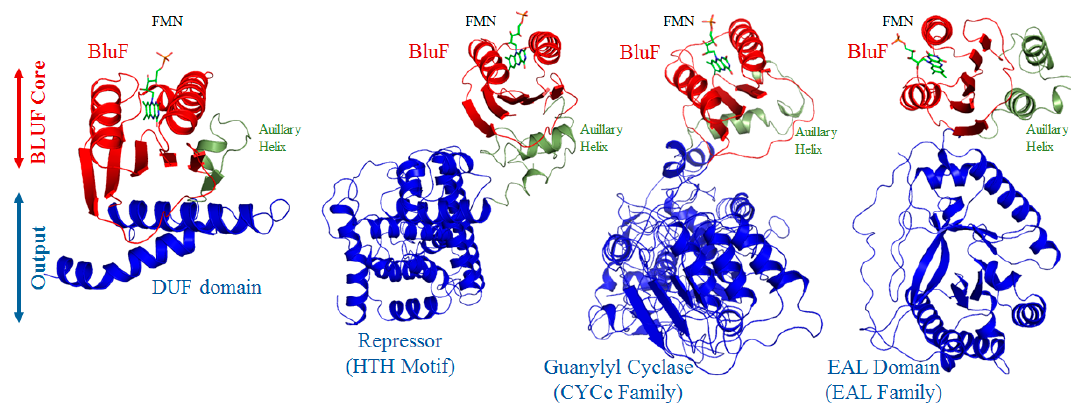
Figure 5. Representation of 3D structural models of BLUF (Red) and e ff ector domain combinations (Blue) using the Phyre server [54]. ( A ) WP_0229622806.1 ( Pseudomonas pelagia ) (206 aa) codes a combination of the BLUF (5–101) and DUF domain (99–181). The model was generated with 100% confidence covering 1–186 residues using the R. sphaeroides AppA (PDB: 4HH0) as the template. ( B ) WP_051596720.1 ( Curtobacterium sp. UNCCL17) (470 aa) codes for BLUF in combination with the transcriptional repressor (224–327). The model was generated with > 90% confidence covering 1–350 residues using 12 di ff erent templates. ( C ) Q8S9F2.1 ( Euglena gracilis ) (1019 aa) codes for BLUF in combination with cyclase homology domains (CHDs), which are part of the class III nucleotydylcyclases (20–379). The model was generated with > 90% confidence covering 1–800 residues using 13 di ff erent templates. ( D ) ARH96915.1 ( Escherichia coli ) (403 aa) codes for BLUF (2–93) in combination with the EAL signaling domain (150–389). The model was generated with 100% confidence covering 1–389 residues using K. pneumoniae BlrP1 (PDB: 3GFZ) as the template. The structures are represented as interactive coloured ribbons. The model images were generated using PyMol (http: // www.pymol.org)